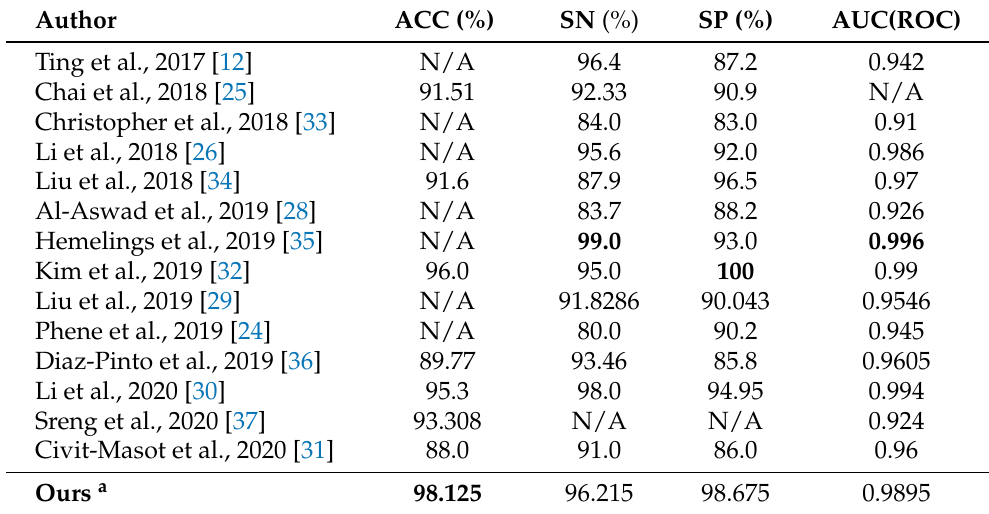
Table 6. Comparison between proposed CAD system for GON classification and currents